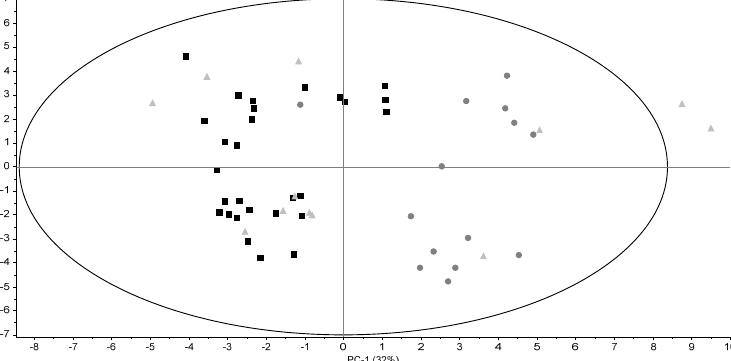
Figure 2. PCA score plots of FA profiles for conventional (black square), organic (dark grey round), and grass (light grey triangle) retail full ‐ fat butters.